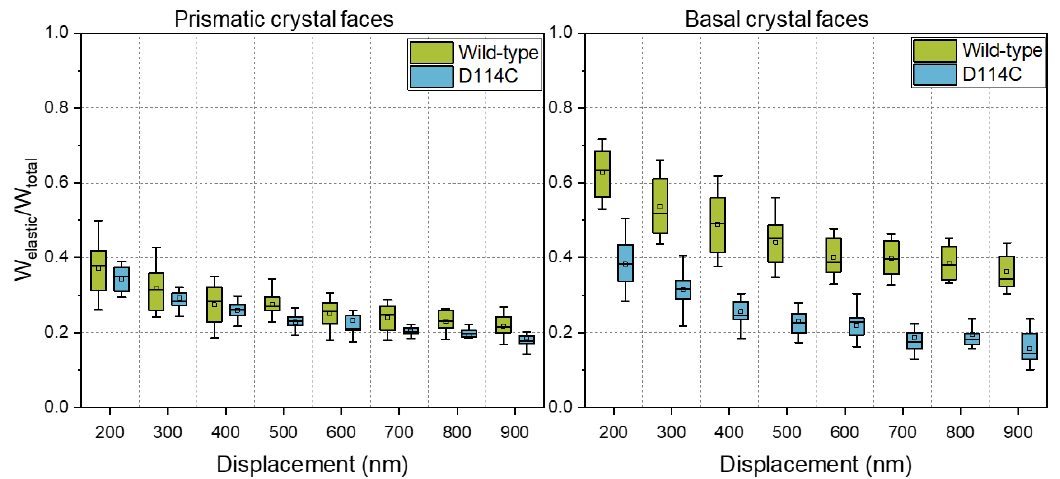
Figure 6. Influence of protein engineering on the fraction of elastic energy of the HheG enzyme crystals.